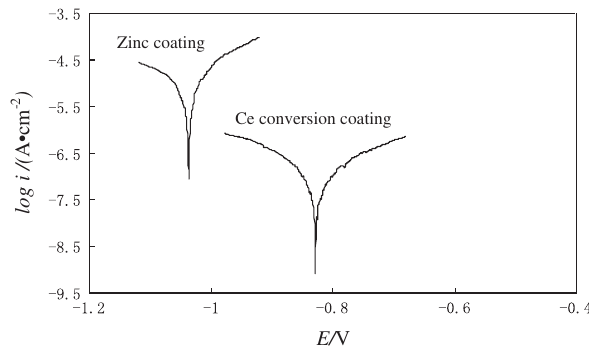
Figure 2: The Tafel curves of zinc coating and cerium conversion coating in a 5% NaCl solution.